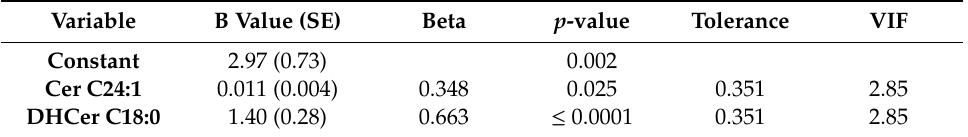
Table 2. Linear regression predicting outcome based on ceramide levels in SBC patients. * R 2 = 0.931, Adj- R 2 = 0.918; F = 74.0 ( p ≤